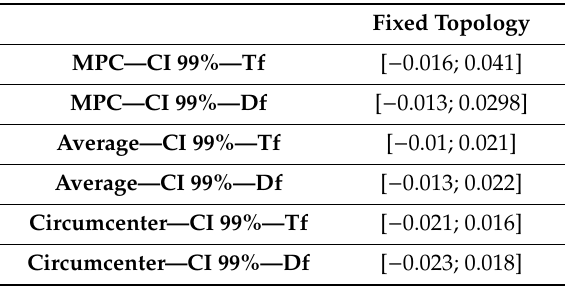
Table 2. Base simulation validation with confidence intervals.